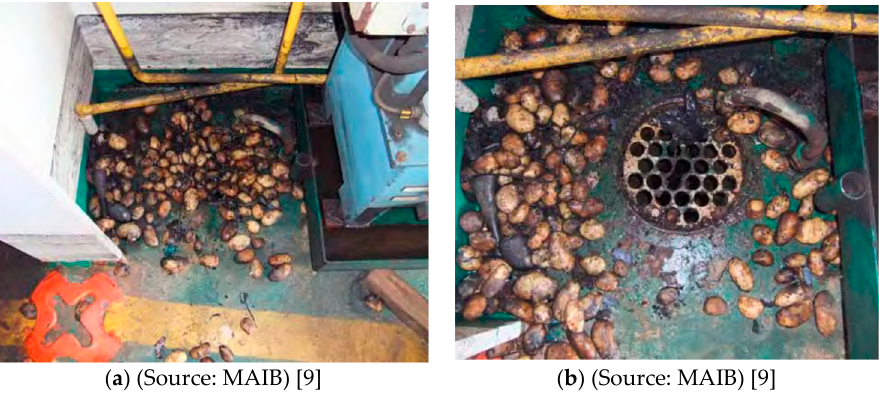
Figure 1. A deck scupper blocked by potatoes. ( a ) Blocked. ( b ) Removed.